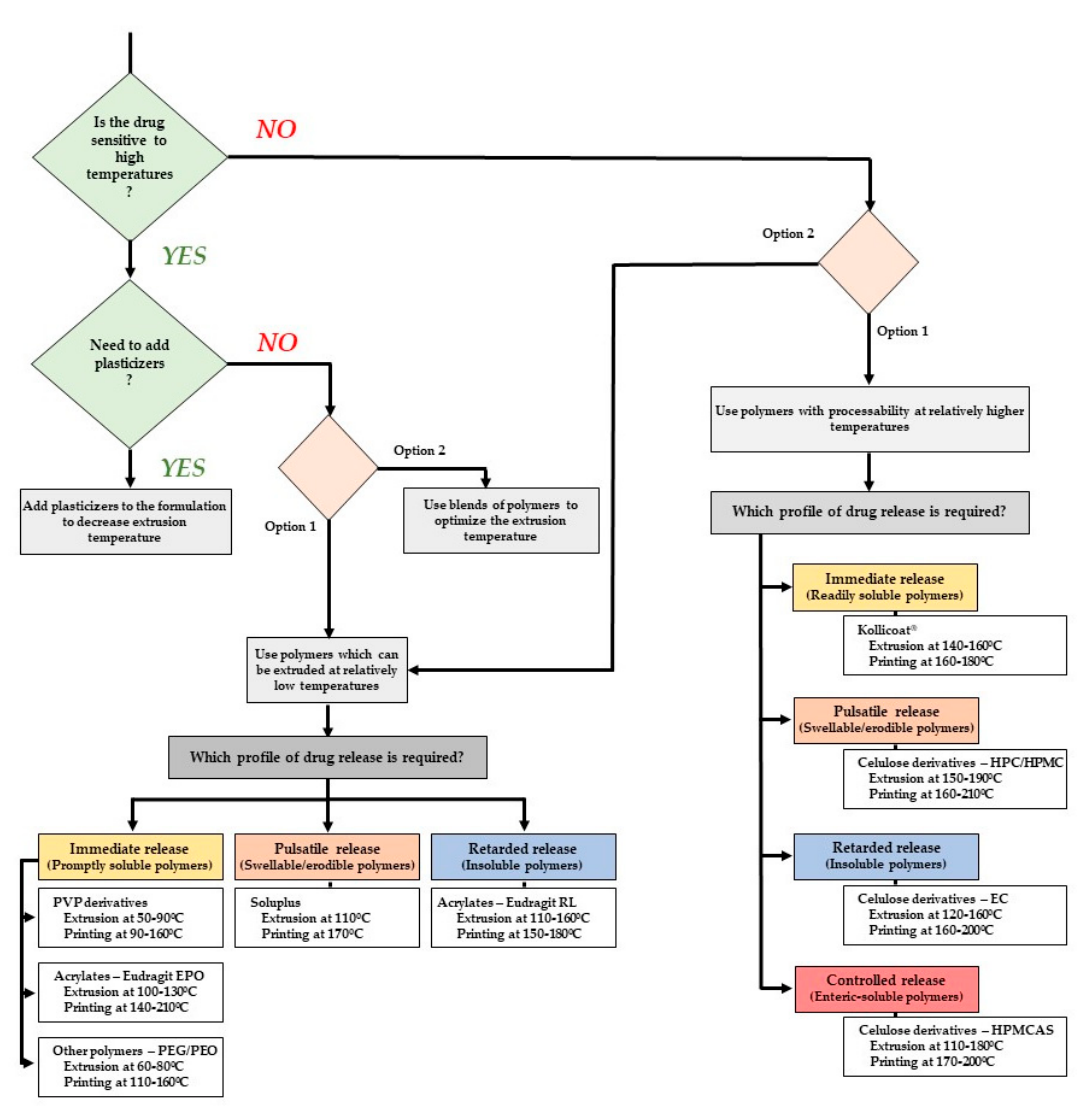
Figure 13. Decision tree for the choice of a polymer for HME coupled to FDM, considering drug thermal sensitivity, impact of thermal properties of the polymer on extrudability/printability, and desired drug release profile.